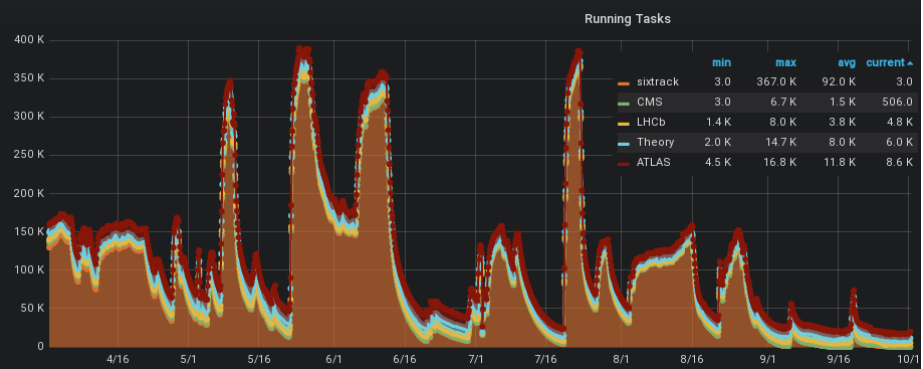
Figure 1. Running tasks on LHC@home over the last 6 months, by application